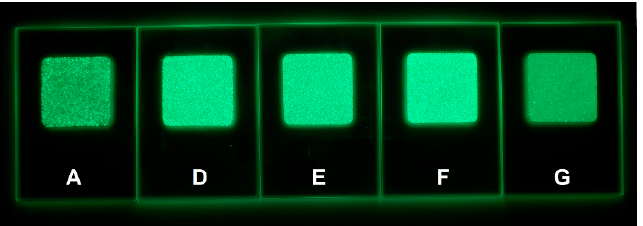
Figure 7. Excitation and emission spectra of the prepared samples by comparison to a commercial sample (CS) samples (color codes: A—red, D—green, E—magenta, F—orange, G—turquoise, CS— black). Images in the dark of the prepared samples after irradiation with VIS light are shown in Figure 8.